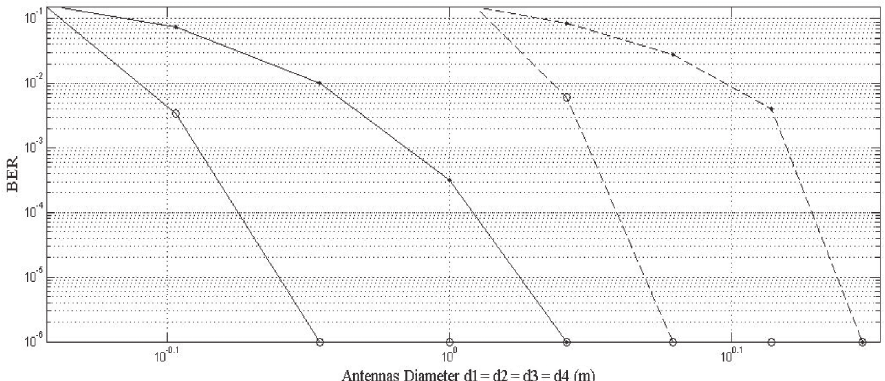
Fig. 3. Dependence of error probability for a BPSK modulation scheme on the diameter of satellite and aircraft antennas: dots indicate values without coding, circles – with convolutional coding (rate ¾, constraint length K = 7); 20 K noise temperatures of satellite and ground receivers are indicated by solid lines and 290 K by dashed lines; phase and frequency offsets are equal to zero; HPAs back-off level is 7 dB, free space path loss is 160 dB; satellite